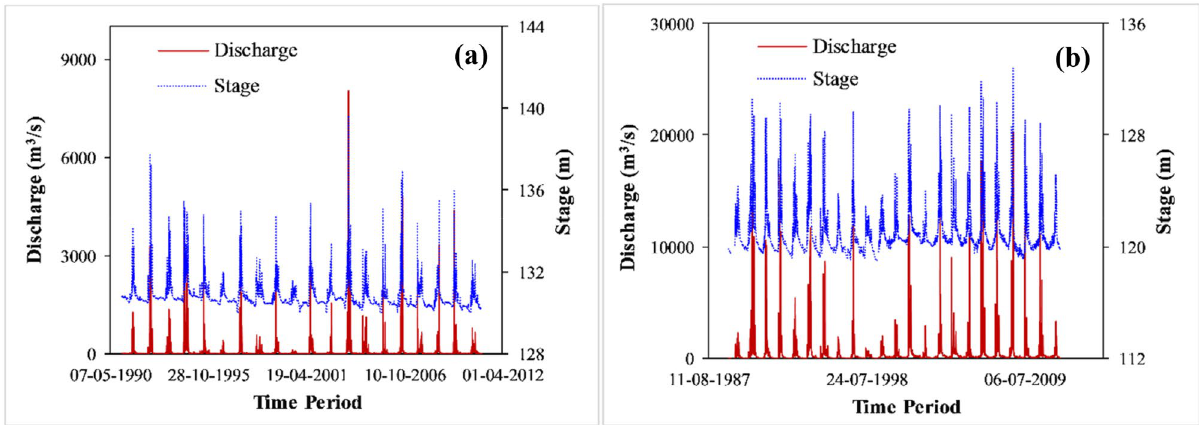
Figure 5. Variation of flow (in m 3 /s) and stage (in m- from MSL) along ( a ) the Ong (1991–2011) and ( b ) the Tel Rivers (1989–2011).